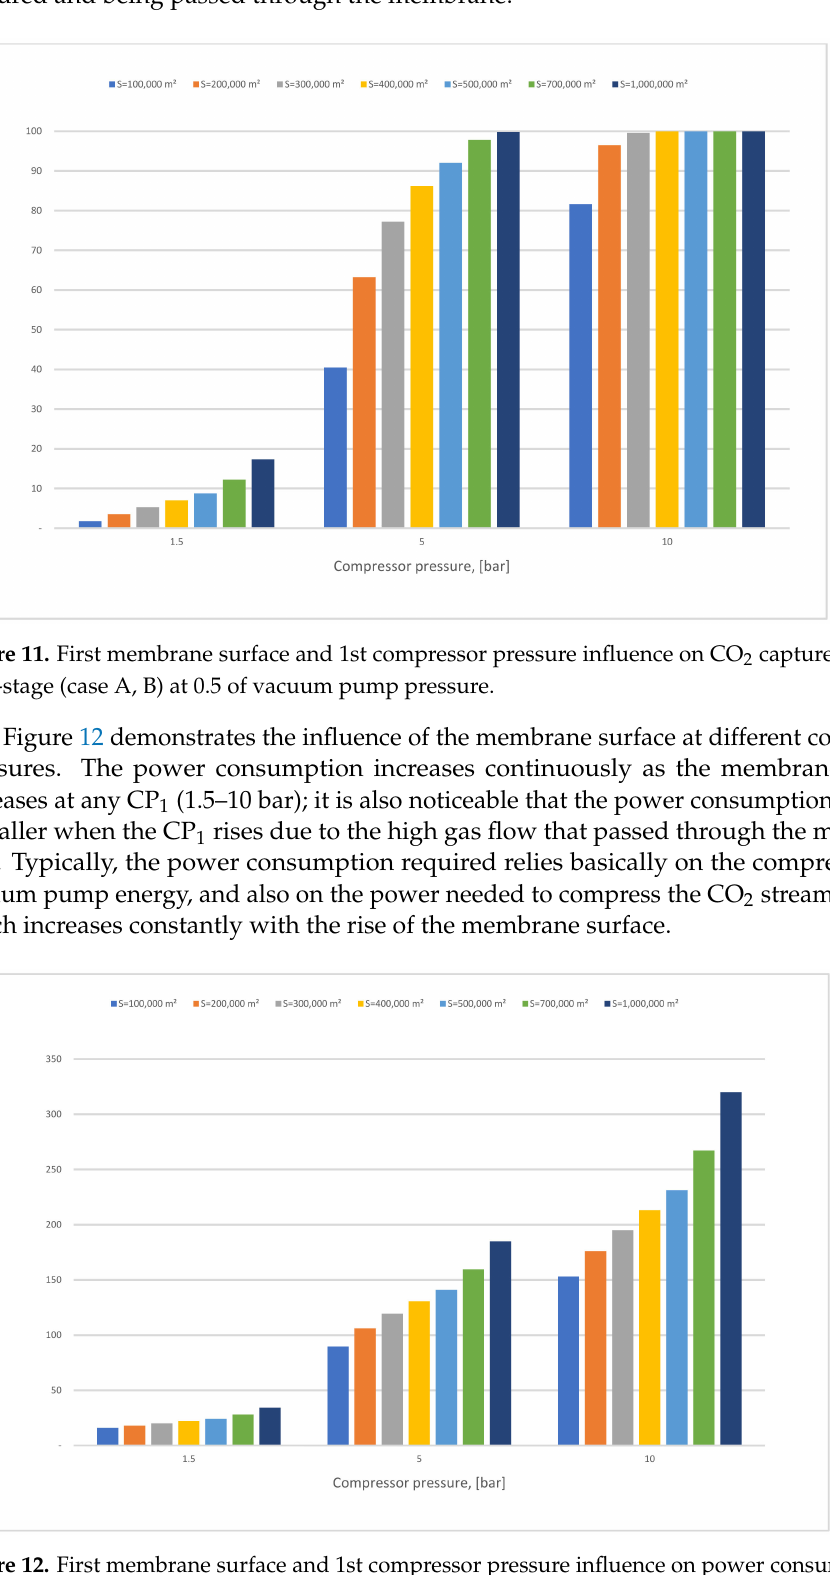
Figure 12. First membrane surface and 1st compressor pressure influence on power consumption for 1-stage (case A, B) and 0.5 bar of vacuum pump